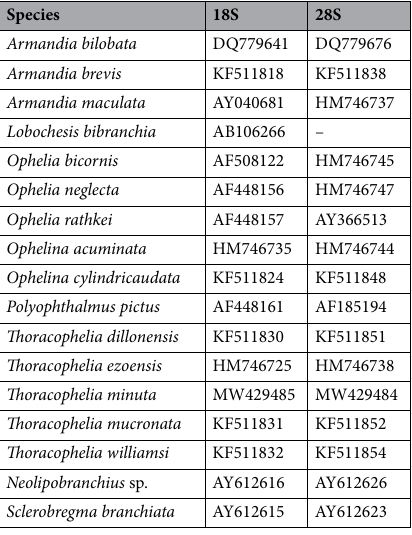
Table 1. List of opheliids and outgroup species included in the phylogenetic analysis, together with accession numbers in